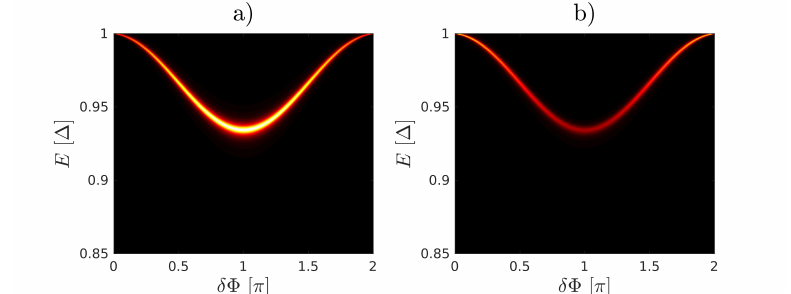
Figure A3. The LDOS for electron ( a ) and hole ( b ) quasiparticles as a function of δ Φ on molecular site 8 of the Andreev interferometer shown in Figure 6c of the main text and in Figure A1. In these calculations we used ε 3 = − 0.50 γ 0